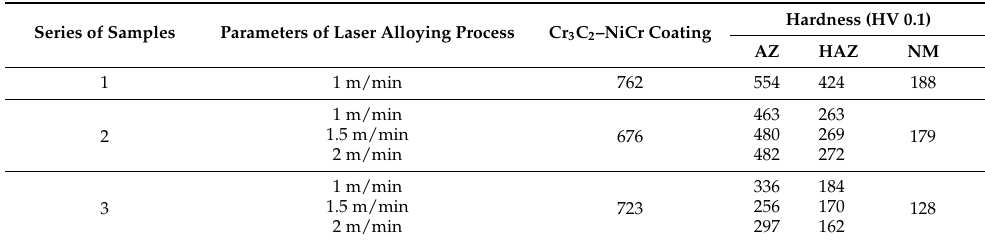
Table 12. Hardness measurements of specimens (AZ—alloying zone, HAZ—heat-affected zone, NM—native material).